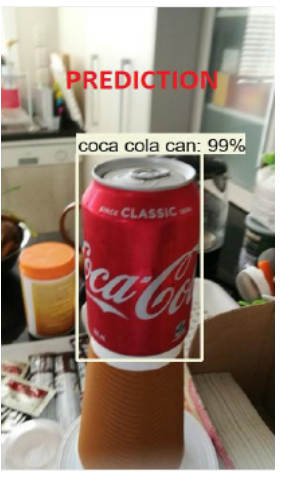
Figure 9. Mobile application results.